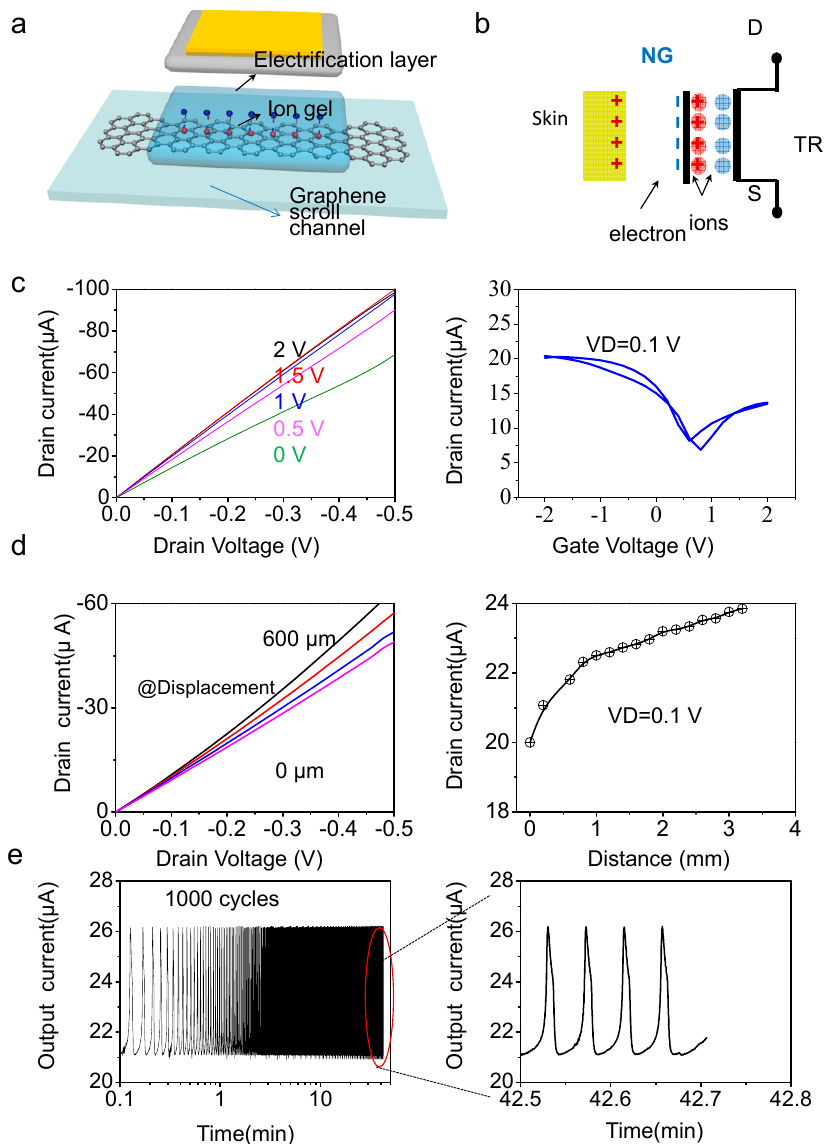
Figure 4. Triboelectric properties of the tribotronic GSFET. ( a ) Schematic illustration of the GSFET device. ( b ) Circuit diagram of tribotronic GSFET sensor contact with skin. ( c ) Output characteristic (left panel) and transfer characteristic (right panel) of GSFET by triboelectric driving. ( d ) Output characteristic (left panel) and transfer characteristic (right panel) of trilayer graphene scroll transistor by tribotronic potential (right panel). ( e ) Durability test over 3000 cycles of contact and separation (left panel) and retentivity during the last cycles (right panel). For E-skin application, ion gel dielectric was carried out friction with skin. Figure 4b shows the scheme of the working principle of ion gel-triboelectric gated GSFET. The tribo-potential, induced by friction between the ion gel and skin, causes the accumulation of negative charges on the surface of the ion gel, attracting compensating cations in the ion gel, while the anions in the ion gel migrate to the ion gel/graphene interface, acting as a negative gating potential for the graphene channel. Consequently, the electrons accumulate in graphene channel. The output characteristic of GFET under an applied gate (Figure 4c left panel) displays that the drain current ( I D ) exhibits a linear relationship with drain voltage V DS and increases values as gate voltage V G increases (from 68.7 μ A to 98.5 μ A with V G increased from 0 V to 2 V at a V D of 0.5 V). The transfer curve (Figure 4c right panel) displays that the I D values increased with increased V G in both positive and negative directions, indicating an ambipolar charge transport property of graphene. The GFET operated at a low gate voltage (<2 V) due to the extreme high capacitance of the ion gel gate dielectric (6–7 μ F/cm 2 ).